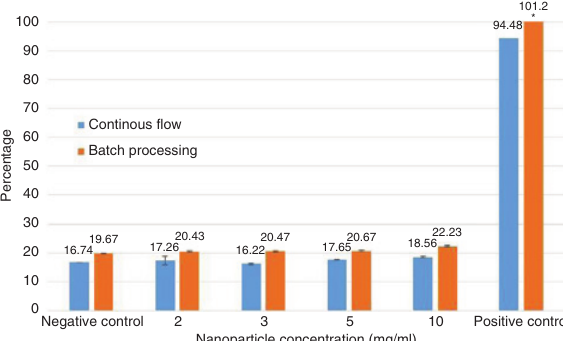
Figure 4: In vitro hemolysis of rat blood exposed to different concentrations of PLGA nanoparticles. Untreated blood sample was used as the negative control (–), and Triton X-10% treated blood was used as the positive control ( + ). Data are presented as means ± SD, n = 3.